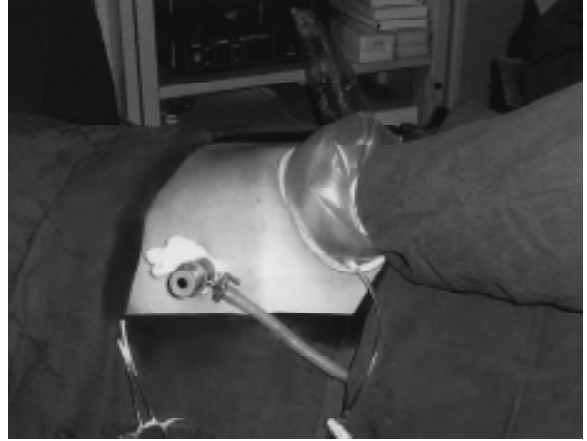
Figure 2 – Device installed for hand-assisted